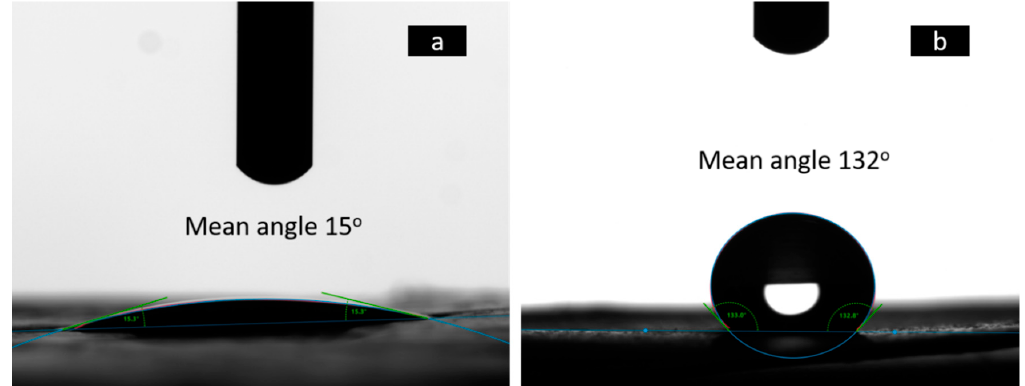
Figure 3. Determination of the wettability characteristics of the scaffold layers by measuring the value of their contact angle: ( a ) the first layer of PG+gen and ( b ) CA—the second layer.